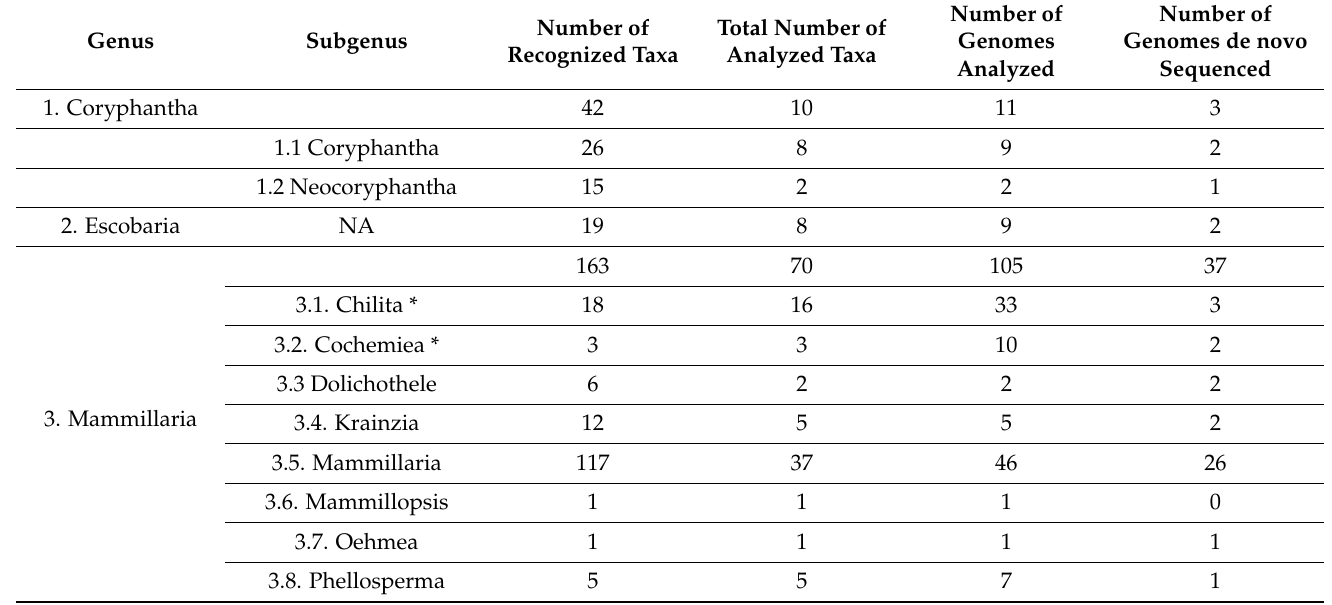
Table 1. Taxon diversity sampled for the seven genera. Taxonomic names and the total number of recognized taxa for the levels of genus and subgenus following Hunt [18]. Total number of the taxa and number of genomes analyzed (in silico plus those de novo sequenced); and the number of genomes de novo sequenced. NA indicates that the subgenus level is not